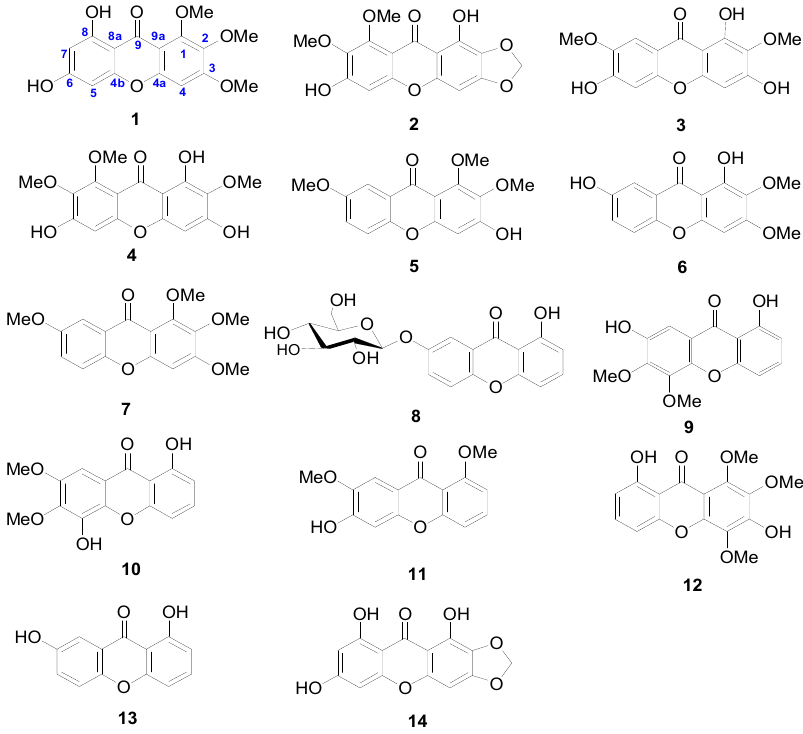
Figure 2. The stucture of the 14 xanthones studied.